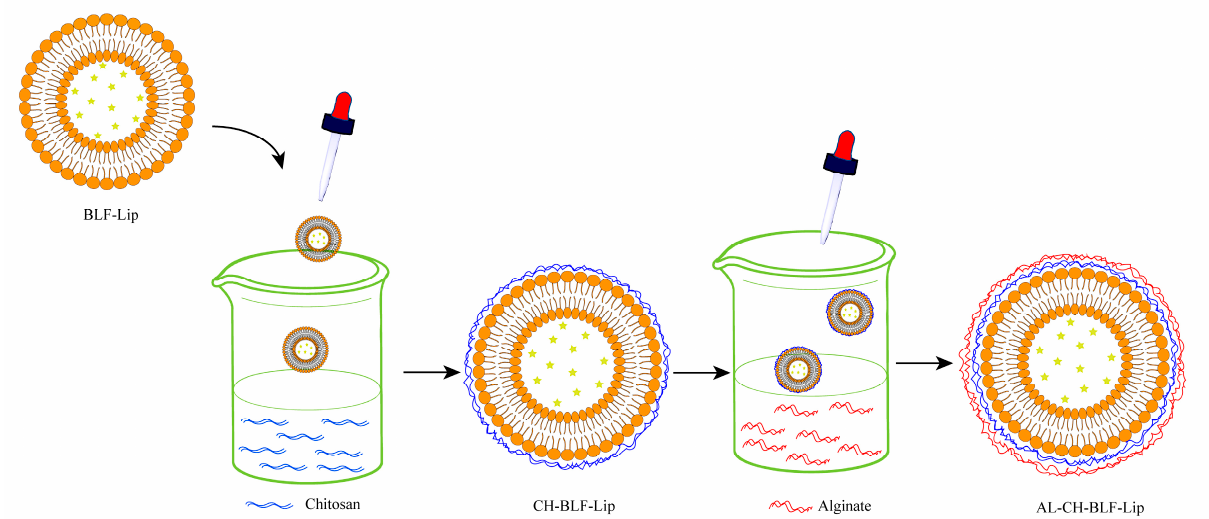
Figure 3. Illustration of the electrostatic deposition of chitosan and alginate layer onto the surface of nanoliposomes. BLF-Lip, BLF-loaded nanoliposomes; CH-BLF-Lip, BLF-loaded chitosan coated nanoliposomes; AL-CH-BLF-Lip, BLF-loaded alginate-chitosan coated